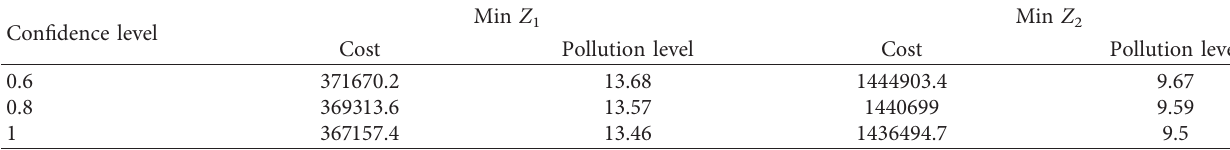
Table 4: Output of the first sample problem.